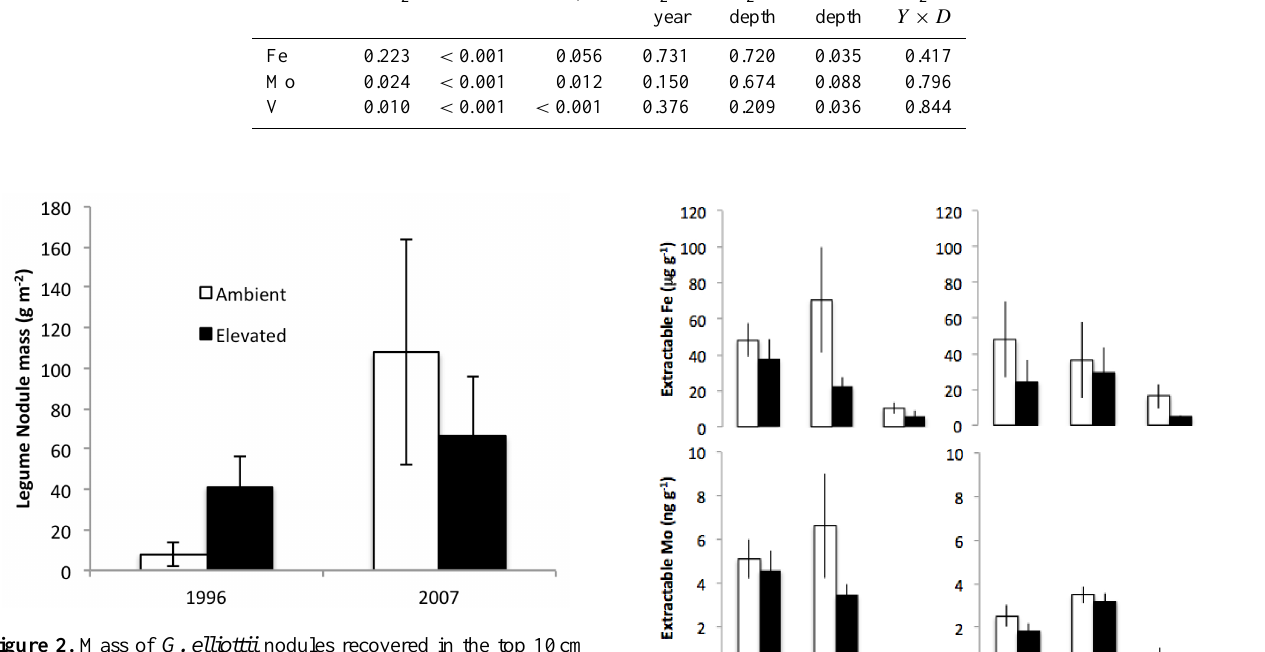
Figure 2. Mass of G. elliottii nodules recovered in the top 10cm of soil in 1996 (from ingrowth soil cores) and in 2007 (from intact cores). Values are means ± standard errors.